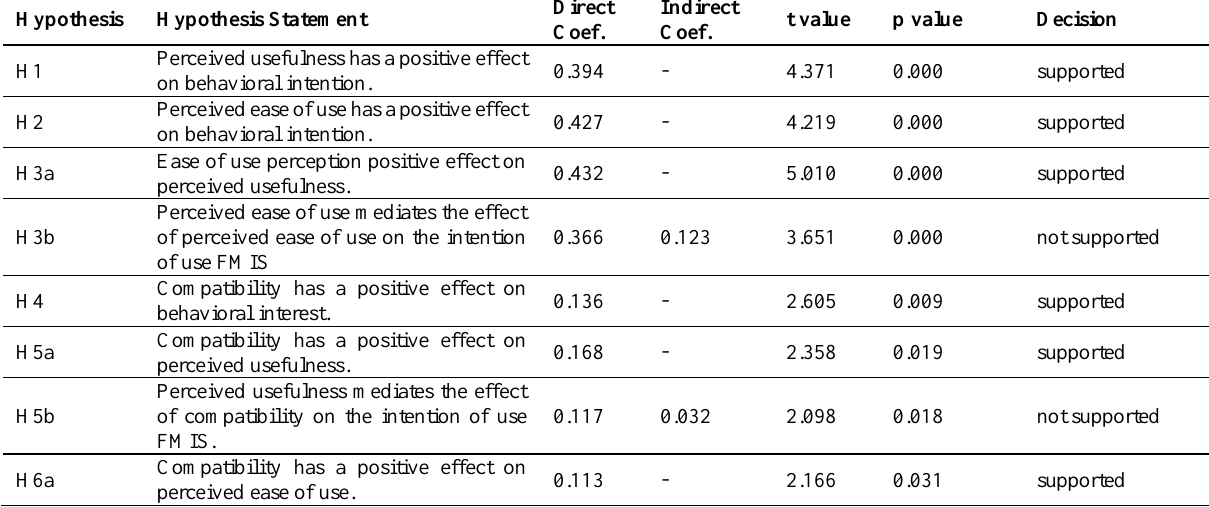
Table 4 : Hypothesis Test